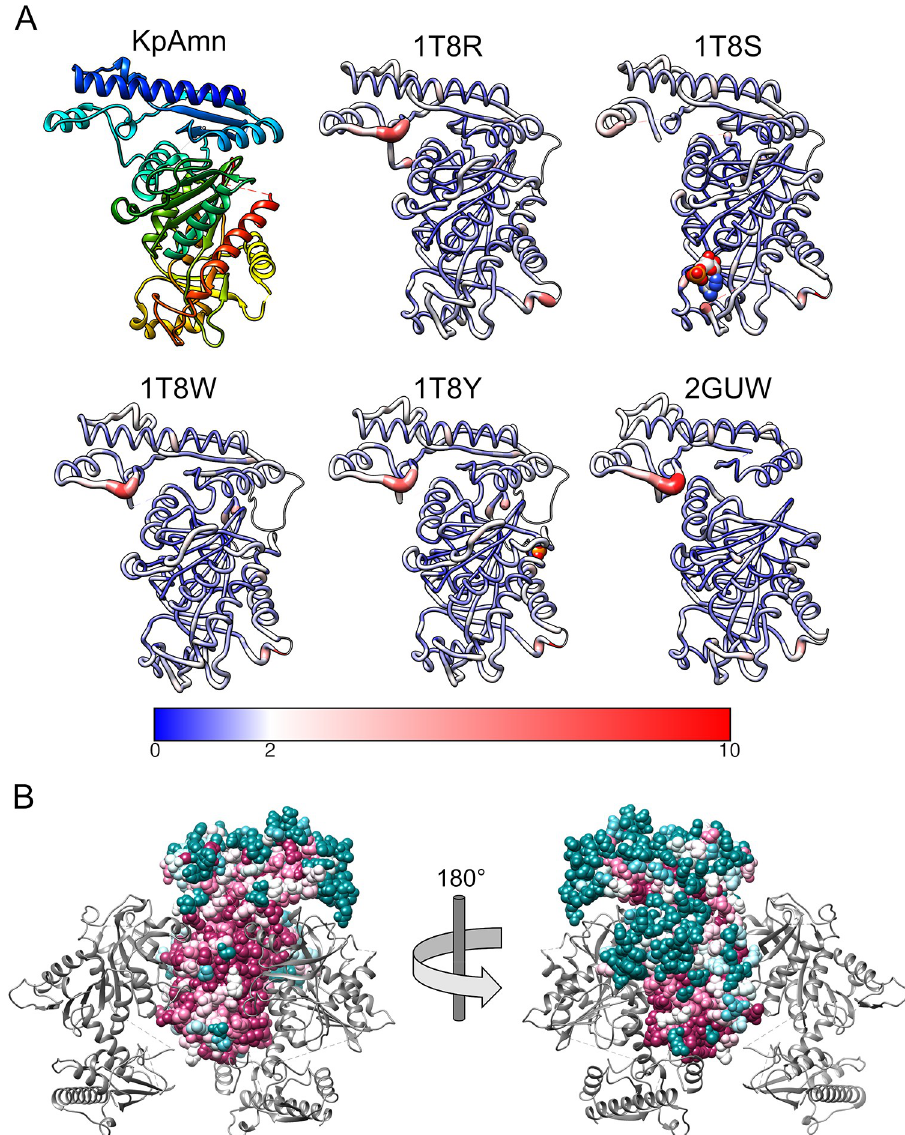
Fig 4. Comparison of Amn between species. All PDB structures identified by BLAST as close Amn homologs were aligned to Amn in UCSF Chimera (A). Color and ribbon width indicate the all-atom spatial distance RMSD of each residue from that of KpAmn; a thin line represents absence of the corresponding loop. Ligands bound by PDB entries 1T8R and 1T8Y are shown as spheres. ConSurf-derived conservation of Amn (B), ranging from low (teal) to high (magenta). The alignment is detailed in S3